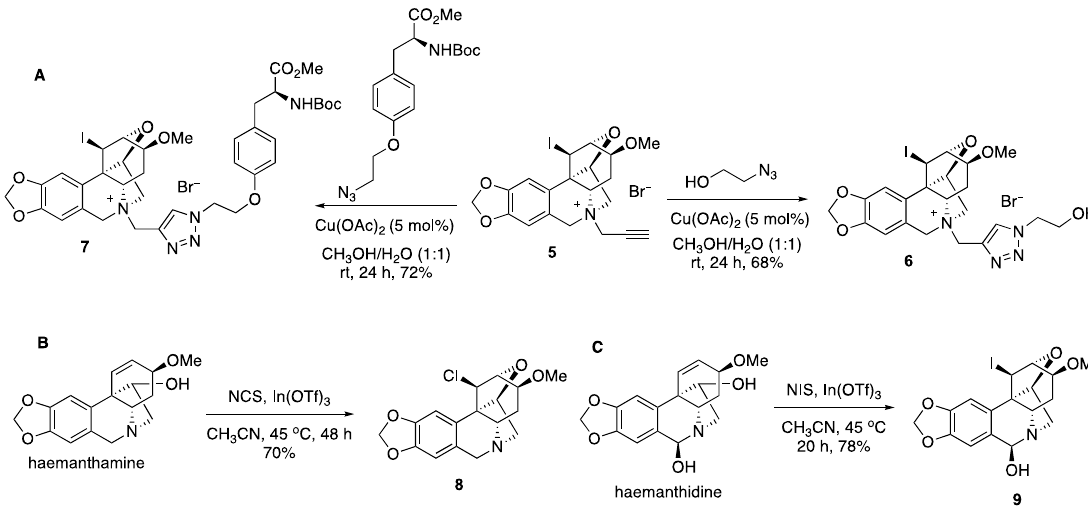
Figure 3. ( A ) Click reactions of compound 5 , ( B ) chloro variant of the original transformation, and ( C ) an analogous transformation of alkaloid haemanthidine.